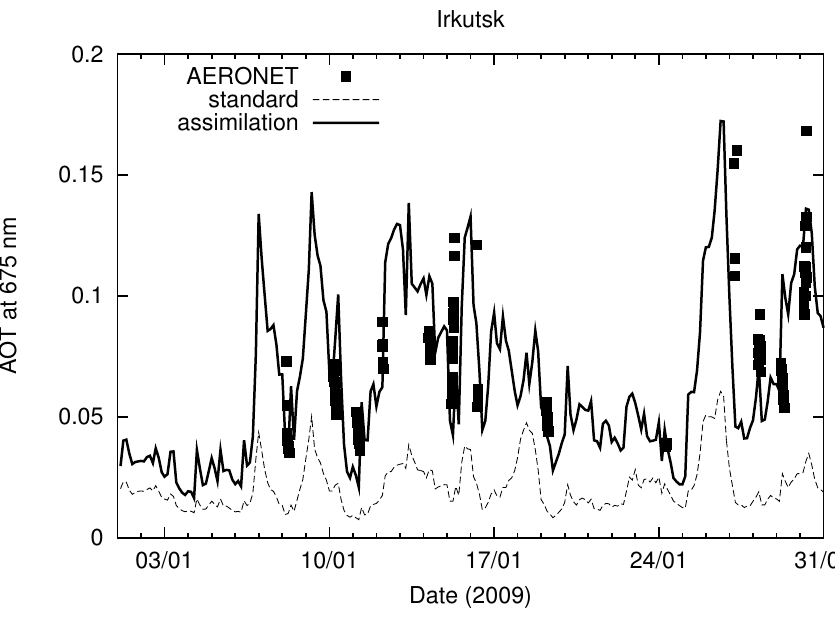
Figure 6. Impact of the new emissions on AOT at Irkutsk, compared with the standard simulation and AERONET observations. In January, Irkutsk is mainly affected by carbon air pollution from nearby industries. For the location of Irkutsk, see Figure